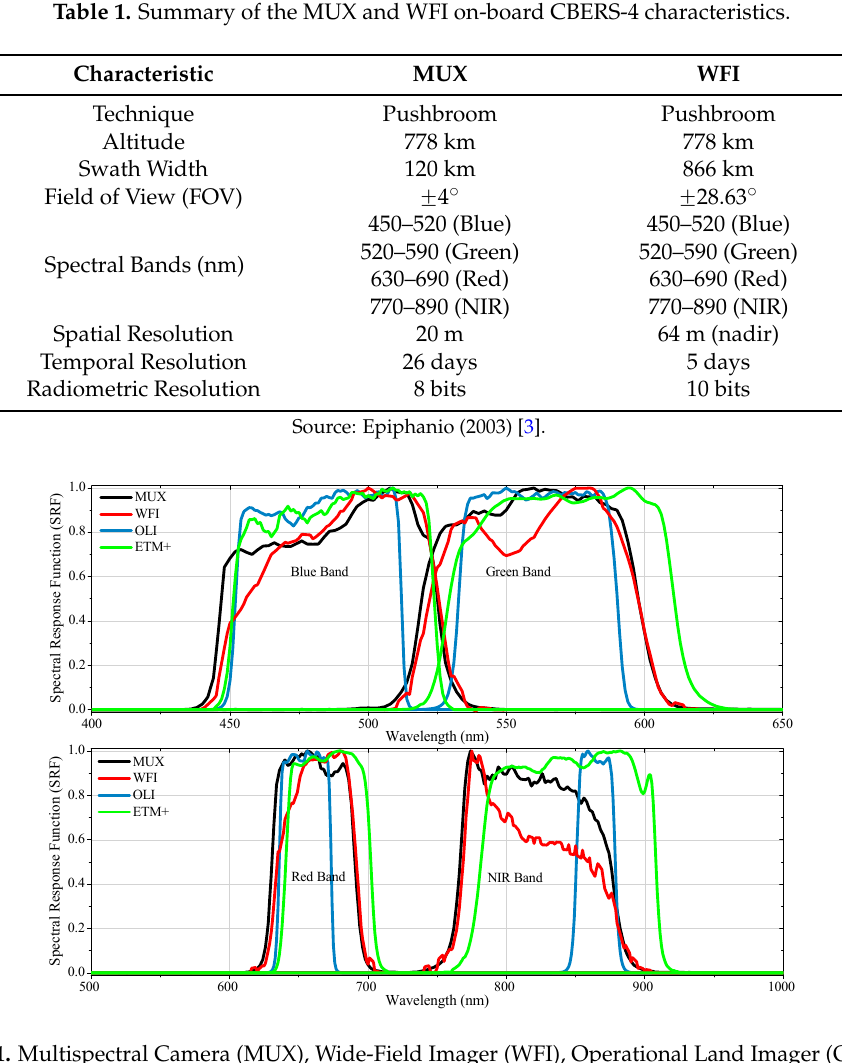
Figure 1. Multispectral Camera (MUX), Wide - Field Imager (WFI), Operational Land Imager (OLI) and Enhanced Thematic Mapper Plus (ETM+) Spectral Response Function (SRF).